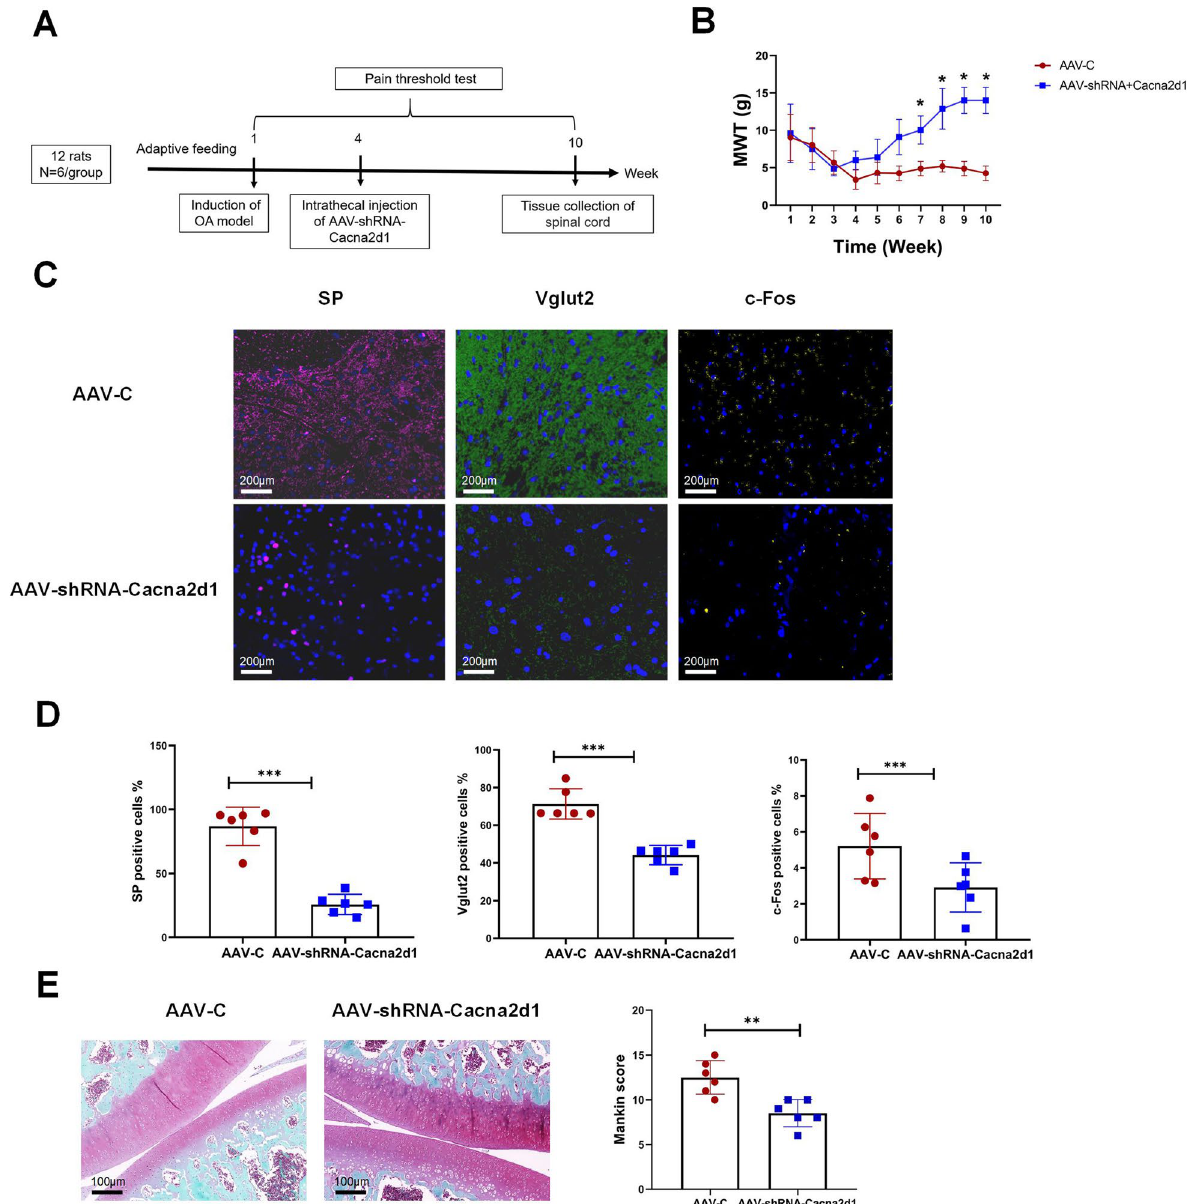
Fig. 3 Cacna2d1 is involved in regulating the release of nociceptive neurotransmitters. A Experimental timeline. In the fourth week of the rat OA model, the AAV specifically knocked down Cacna2d1 by intrathecal injection. AAV-C is as control. Pain thresholds were assessed weekly. B AAV-shRNA- Cacna2d1 rats increased the pain thresholds from 7th week to 10th compared with AAV-C rats. n 6 rats/group, repeated = measures analysis of variance, Tukey and Bonferroni tests was used as a post hoc test. C – D Representative images of immunofluorescence (scale bar 200 um) and quantification of Vglut2, SP, c-Fos in the posterior horn of the spinal cord. n 6/group. The independent sample T test was used = = for comparison, and Levene’s test for homogeneity of variance. * P < 0.05, *** P < 0.001 as indicated. E Representative Safranin-O staining image (scale bar 100 μm) and Mankin score ( n 6/group). The independent sample T-test was used for comparison, and Levene’s test for homogeneity of = = variance. ** P < 0.01 as indicated. Blue staining for bone and red staining for cartilage